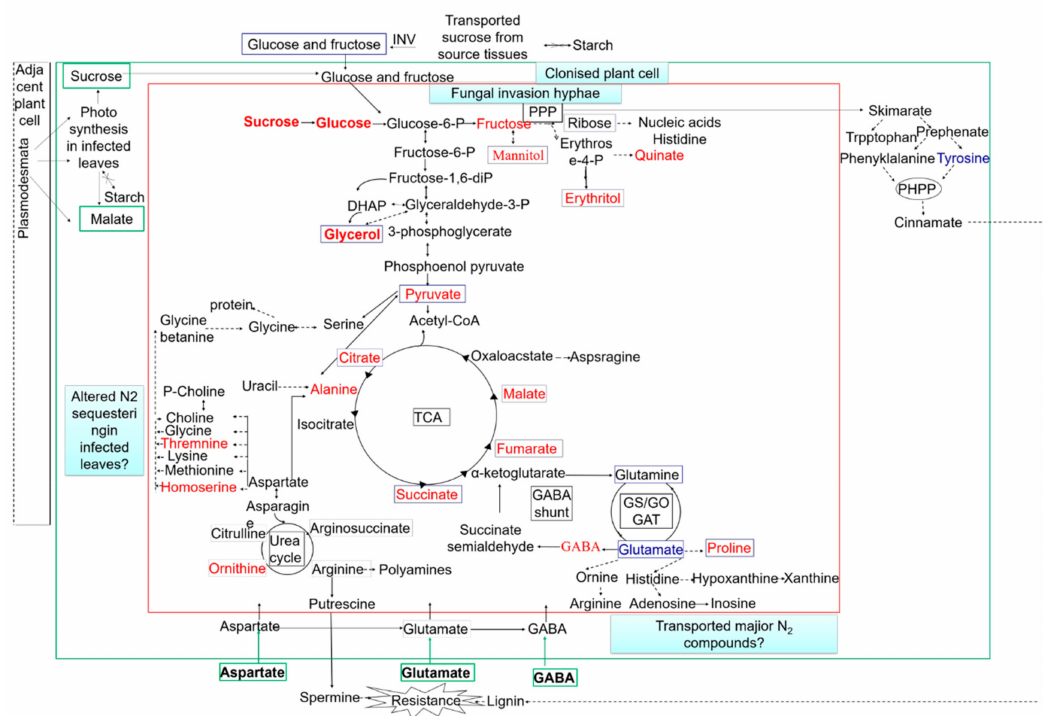
Figure 3. Model summarizing fungal metabolic interactions with the colonized host. INV, invertase; PPP, pentose phosphate pathway; PHPP, phenylpropanoid pathway; TCA, tricarboxylic acid cycle. The metabolites in blue boxes are fungal metabolites that are predicted to increase after 3 days. The metabolites in green boxes are the major central carbon and nitrogen compounds that are likely to be derived from the host. Red font represent the upregulation metabolites; blue font represents the downregulation metabolites. The green arrows indicate transport across cell walls. The dotted arrows indicate multiple enzymic